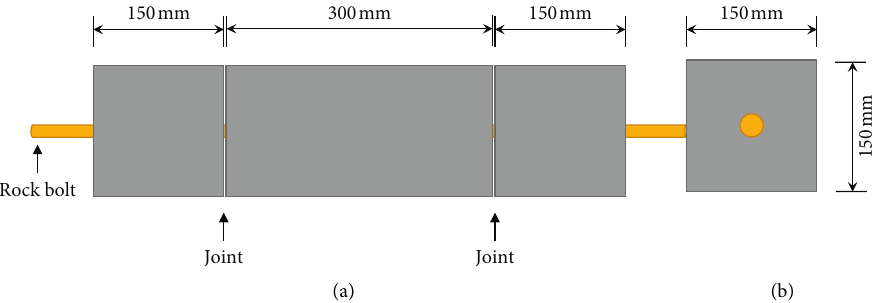
Figure 10: Rock bolt embedded in double-jointed concrete block: (a) side view; (b) front view.